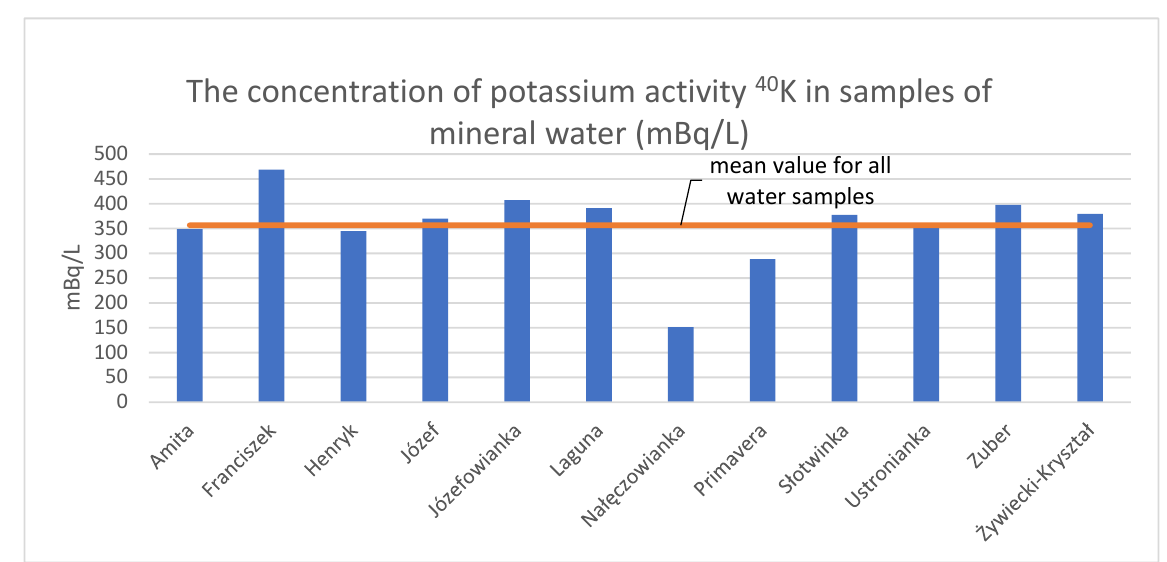
Figure 1. Concentration of 40 K potassium activity in the samples of mineral waters. The orange line represents the mean value for the set of samples.